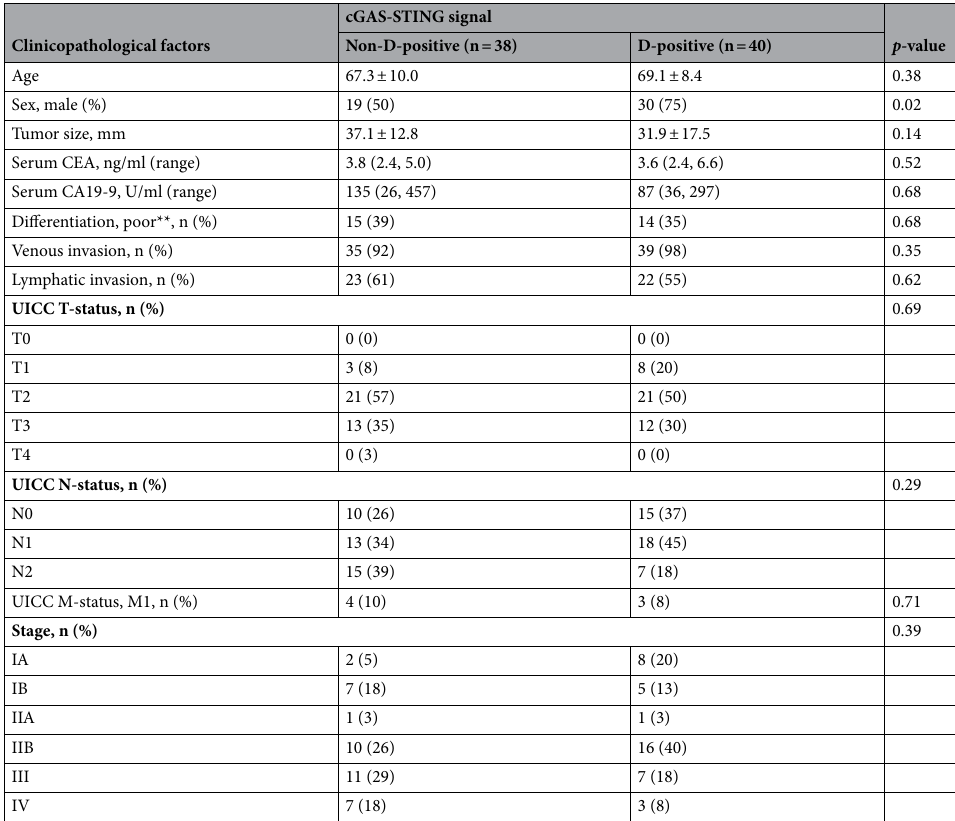
Table 3. Clinicopathological backgrounds of 78 PDAC samples. UICC, Union for International Cancer Control; D-positive, cGAS and STING expression double-positive; **Indicates the cases which contain poorly differentiated components in the specimen. Continuous variables were summarized as a mean ± SD (standard deviation) or median (interquartile range Q1–Q3). UICC T-status: group comparison was performed patients with T0–2 and those with T3–4. UICC N-status: group comparison was performed patients with N0–1 and those with N2. Stage: group comparison was performed patients with IA–IIB and those with